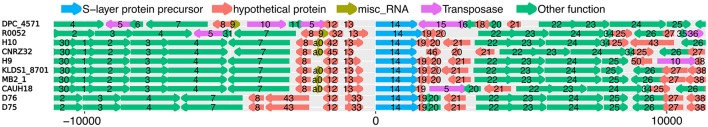
Comparison of the slpH gene (14) and surrounding genes of 10 L. helveticus strains. The complete genome sequences were retrieved from GenBank. Orthologous gene clusters were determined using Ortho-MCL. Genes belonging to the same orthologous gene cluster are depicted as arrows with the same number. The different colors represent different gene functions.